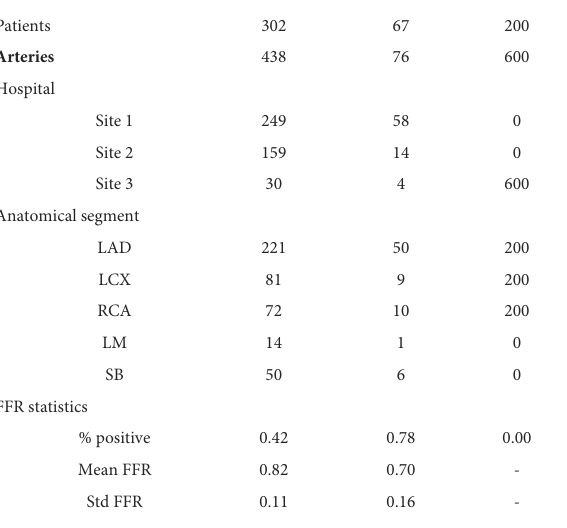
TABLE 2 Data set for training and validation (Development), and two separate test sets, one with FFR measurements (Test Cath ) and one without (Test NoCath